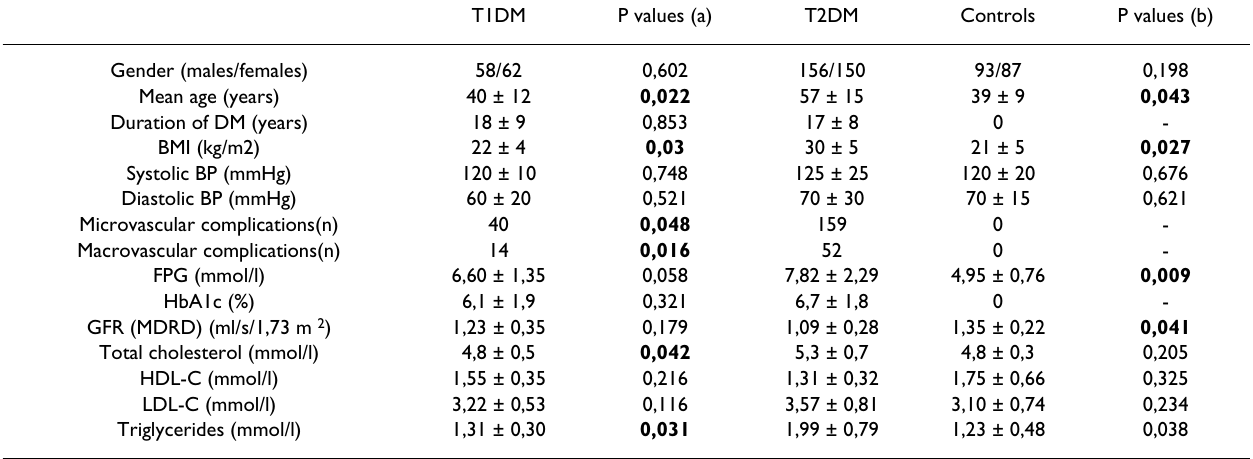
Table 1: Clinical and laboratory